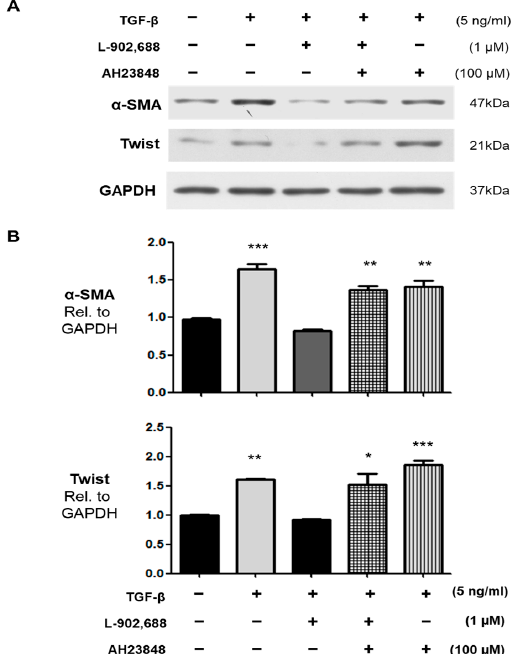
Figure 2. The EP4 inhibitor AH23848 blocks the L-902,688-induced suppression of TGF- β -induced EndMT in HUVEC. TGF- β -induced expression of the EndMT markers α -SMA and Twist in endothelial cells was suppressed by L-902,688. The endothelial cells were stimulated for 30 min with 100 µM AH23848 with or without L-902,688 or TGF- β for 24 h. Data are the mean ± SE of three different experiments. * p < 0.05, ** p <0.01, and *** p < 0.001 versus untreated group. ( A ) Representative immunoblots showing that the suppression of TGF- β -induced expression of α -SMA and Twist by 1 µM L-902,688 was reversed with an EP4 inhibitor (AH23848) at 100 µM. ( B ) Densitometry quantification of α -SMA and Twist expression following EP4 inhibitor treatment in endothelial cells.